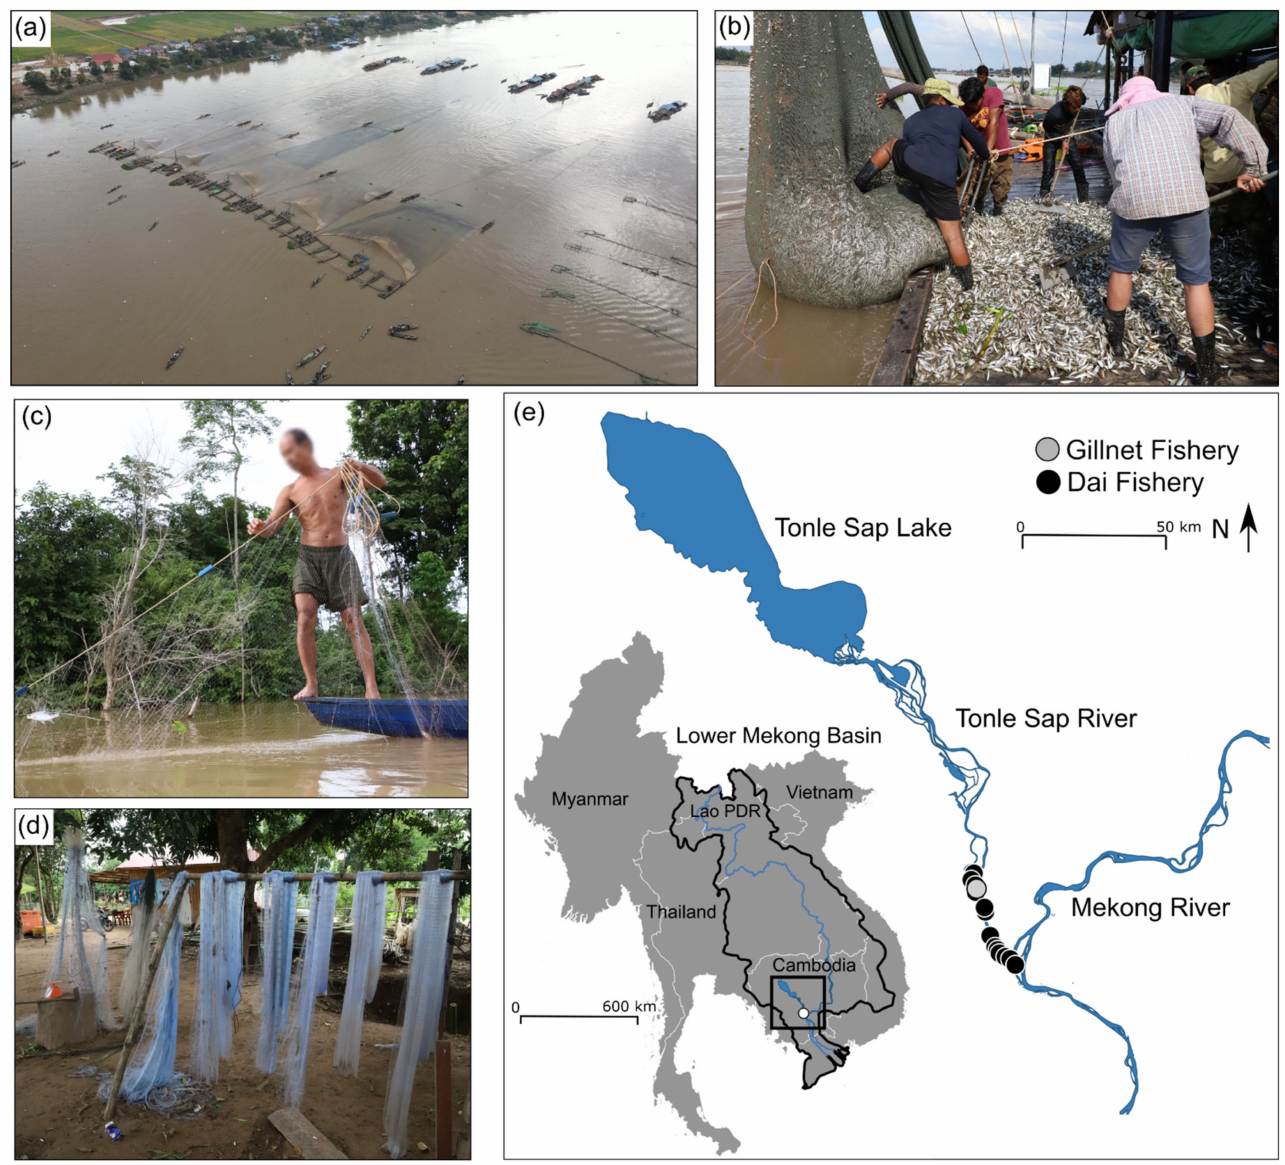
Figure 1. ( a ) Aerial view of one of the 14 rows with several bagnets in the well-established Dai fishery in the Tonle Sap River. ( b ) Fishermen hauling a net in the Dai fishery. ( c ) A fisher pulls in a gillnet, with a single fish in the net, from a slow edge habitat. ( d ) Gillnets can be spotted drying in a village. The photographs contrast the organized, industrial nature of the Dai fishery with the small-scale and independent but ubiquitous gillnet fisheries. ( e ) Map of the Dai fisheries and the monitored stationary gillnet in the Tonle Sap River within the Lower Mekong Basin. Photos by Chhut